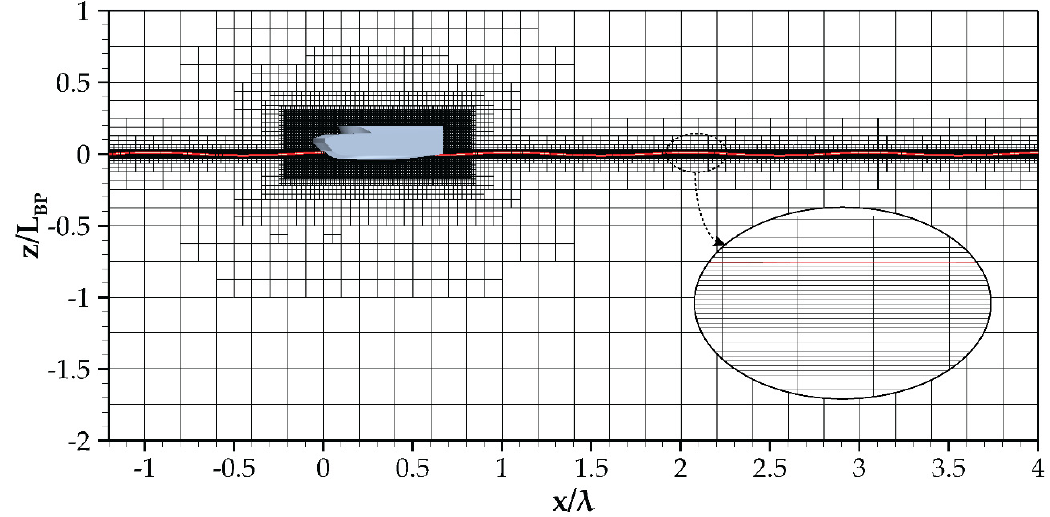
Figure 6. Discretization of the free surface and generated wave profile on XZ-plane.